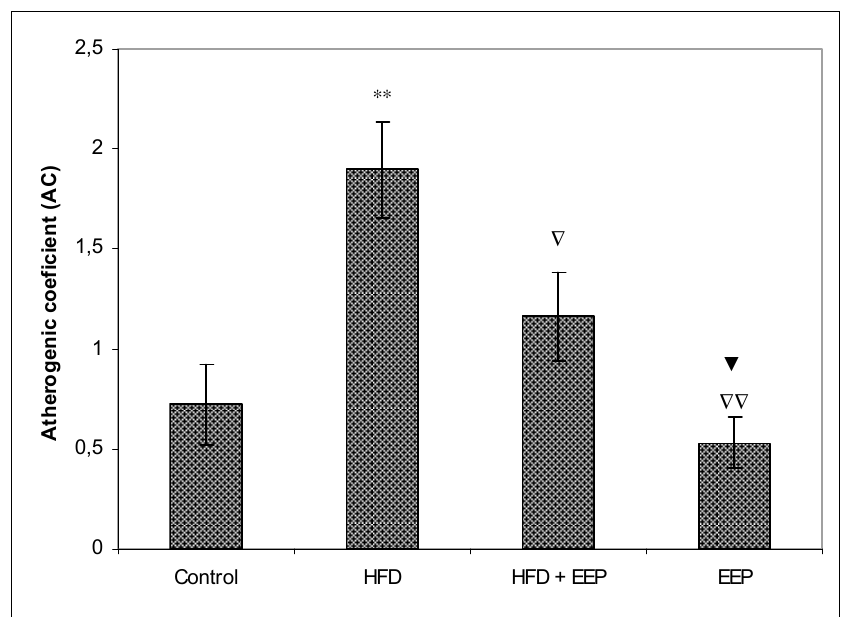
Figure 6. E ff ect of ethanol extract of propolis on atherogenic coe ffi cient (AC). Mice were given HFD, Figure 6. Effect of ethanol extract of propolis on atherogenic coefficient (AC). Mice were given HFD, HFD + EEPatadose50mg / kgorEEP(50mg / kg)oncedailyfor30daysbyasingleintragastricapplication. HFD + EEP at a dose 50 mg/kg or EEP (50 mg/kg) once daily for 30 days by a single intragastric Atherogenic coe ffi cient was calculated according to the formula: AC = [TC − HDL-c / HDL-c]. Number application. Atherogenic coefficient was calculated according to the formula: AC = [TC – of mice per groups: nine. *: Significantly di ff erent from the control group (** p ≤ 0.01). ∇ Significantly HDL-c/HDL-c]. Number of mice per groups: nine. *: Significantly different from the control group di ff erent from the HFD group ( ∇ p ≤ 0.05; ∇∇ p ≤ 0.01). (cid:72) Significantly di ff erent from the HFD + EEP ( ∗∗ p ≤ 0.01). ∇ Significantly different from the HFD group ( ∇ p ≤ 0.05; ∇∇ p ≤ 0.01). ▼ Significantly group ( (cid:72) p ≤ 0.05). TC: total cholesterol. different from the HFD + EEP group ( ▼ p ≤ 0.05). TC: total cholesterol.